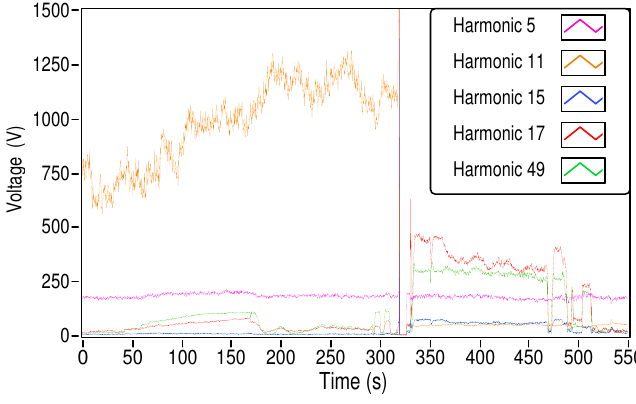
Figure 5. Voltage harmonics during the train journey.